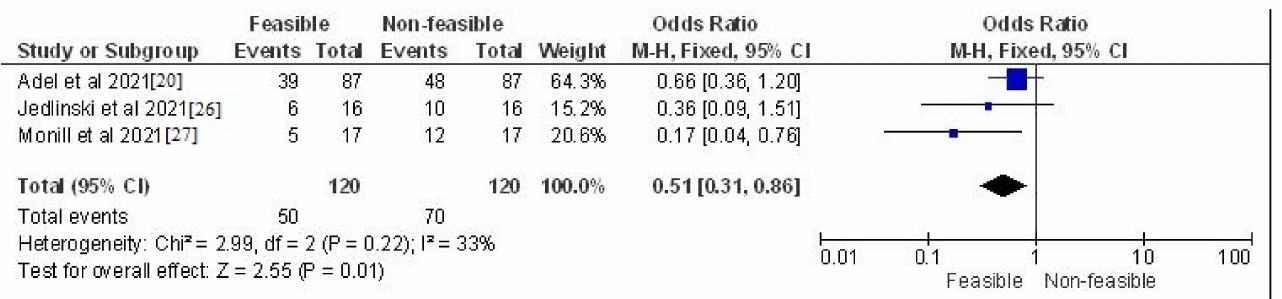
Figure 3. Risk ratio of in-vitro, observational and cohort-based studies selected in this systematic review which assessed the feasibility vs. non-feasibility rates of their respective trends represented on a forest plot after meta-analysis [23,30,32,34,35].